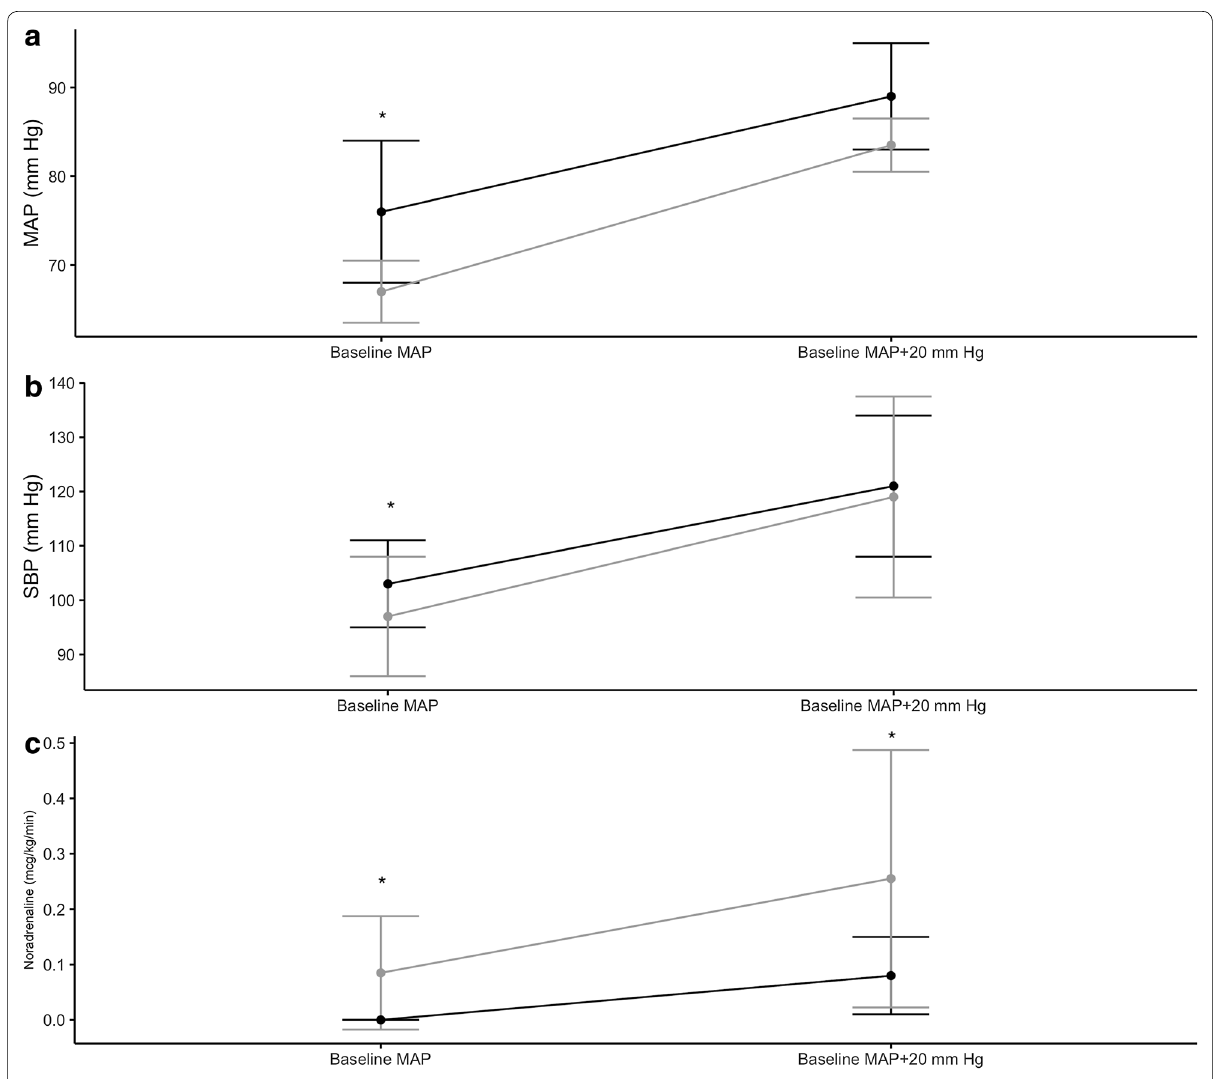
Fig. 2 Dynamics of mean arterial pressure (MAP) ( a ), systolic blood pressure ( b ) and dose of noradrenaline ( c ) before and after adjustment of noradrenaline to increase MAP by 20 5 mm Hg in sepsis (black) and septic shock patients (gray). Data are expressed as median and interquartile ± range. * p < 0.05 sepsis vs. septic